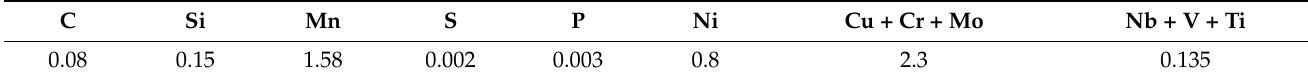
Table 1. Chemical composition of FH690 offshore steel (wt %, balance Fe).